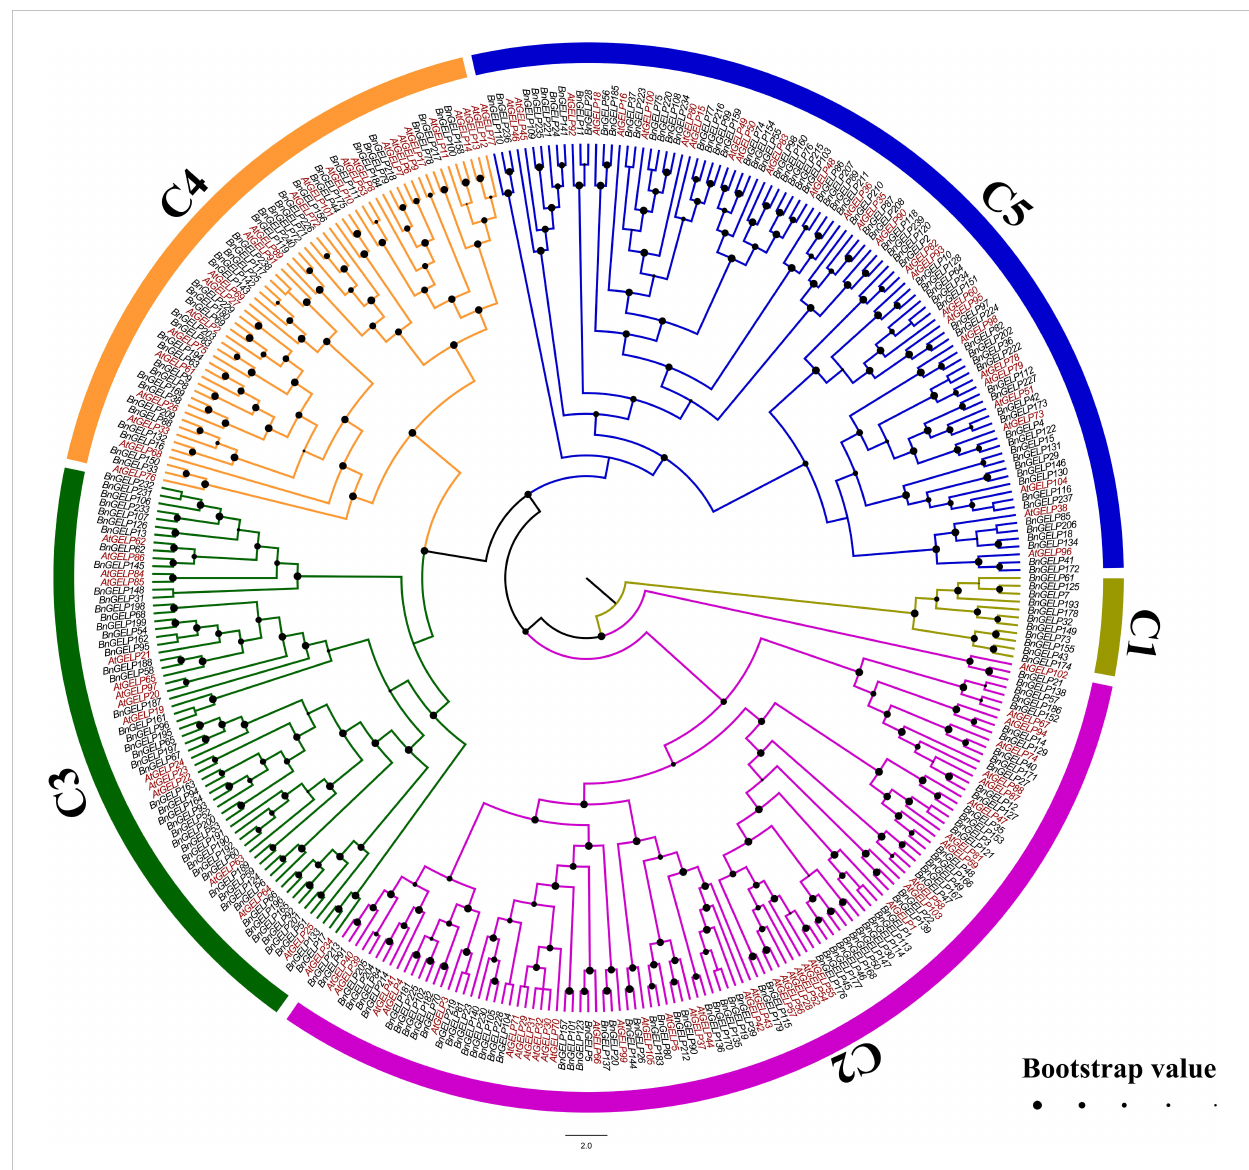
FIGURE 1 Phylogenetic analysis of GSDL-type Esterases/Lipases from B . napus and A . thaliana. The sequences of 240 BnGELP and 105 AtGELP proteins were aligned by the MUSCLE tool. A phylogenetic tree was generated using MEGA 11 with the neighbor-joining (NJ) method (bootstrap replications, n=1000). The phylogenetic tree was highlighted with FigTree (version 1.4.4). The proteins are clustered into 5 distinct clades designated with a clade number (C1~C5) and labelled with different